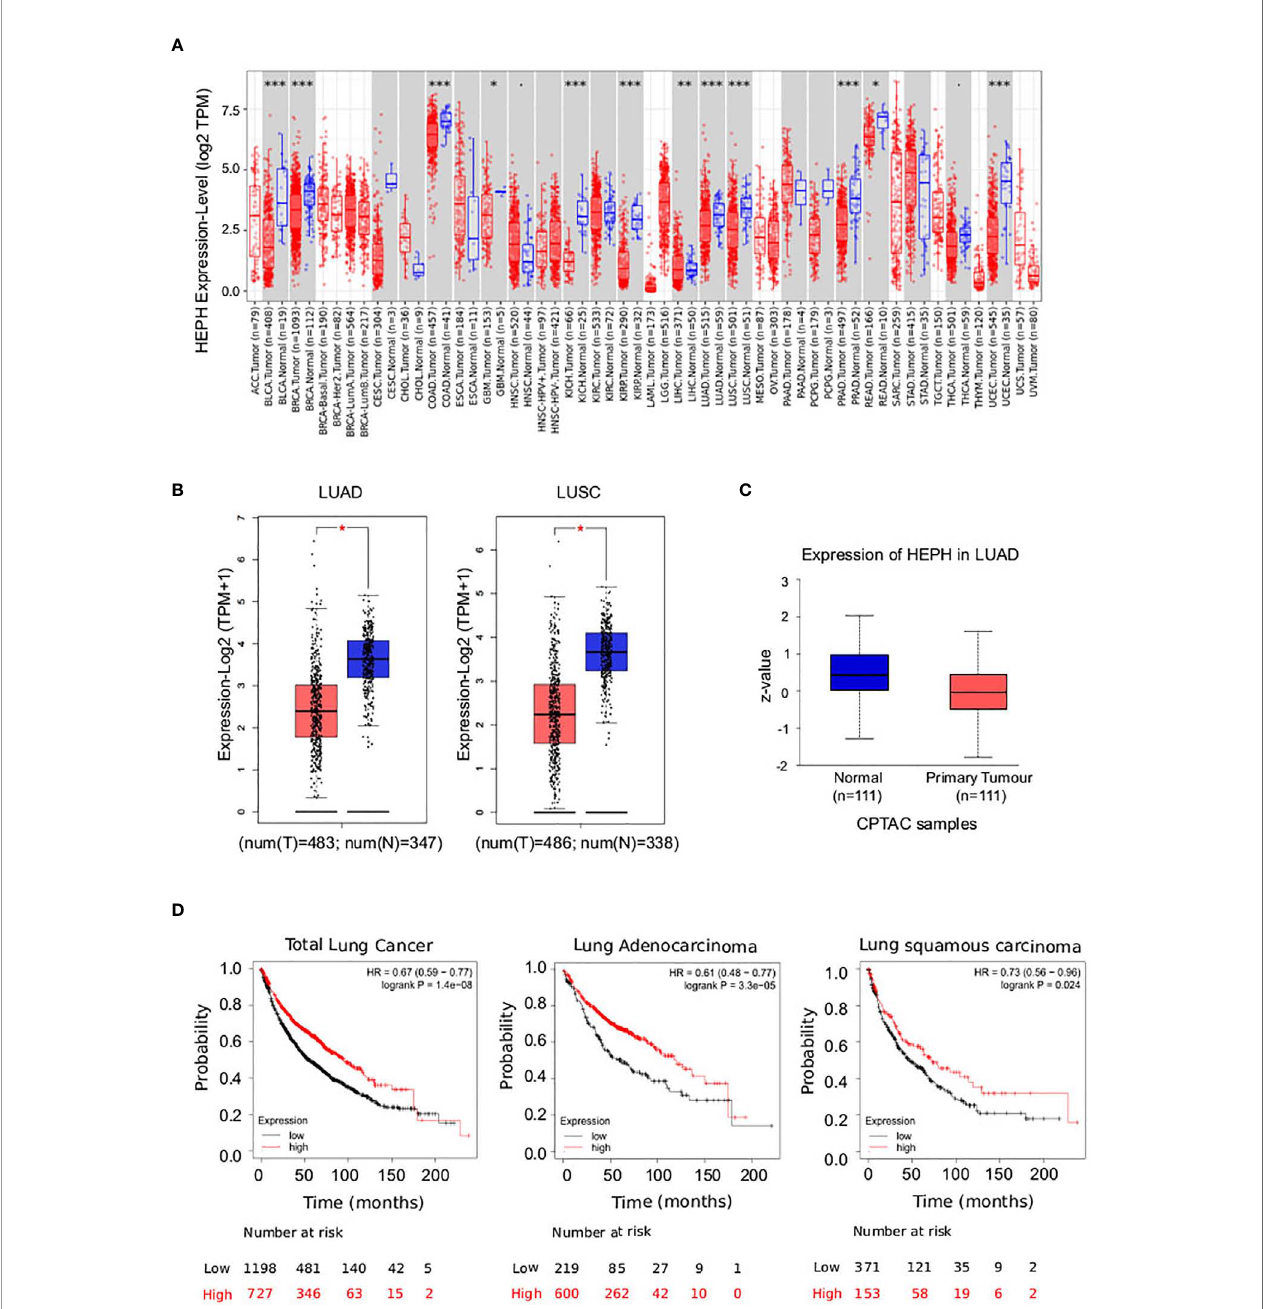
FIGURE 1 | Pathological signi fi cance of HEPH expression in different types of human cancer, and in-depth evaluation in LUAD and LUSC. (A) Human HEPH expression levels in different tumor types from TCGA database were determined by TIMER (*P < 0.05, **P < 0.01, ***P < 0.001). (B) HEPH mRNA expression comparisons between normal (blue) and tumor tissues (red) obtained from the GEPIA web tool. (C) HEPH protein expression comparison between normal and tumor tissues obtained from the UALCAN web tool (Wilcoxon test). P-value <0.05 was used to assess differences. (D) Survival analyses of HEPH by Kaplan – Meier estimator with log-rank test obtained from the Kaplan – Meier plotter web tool. Survival differences are compared between patients with high (red) and low (black) HEPH expression (grouped according to Auto select best cut-off). H, high expression; L, low